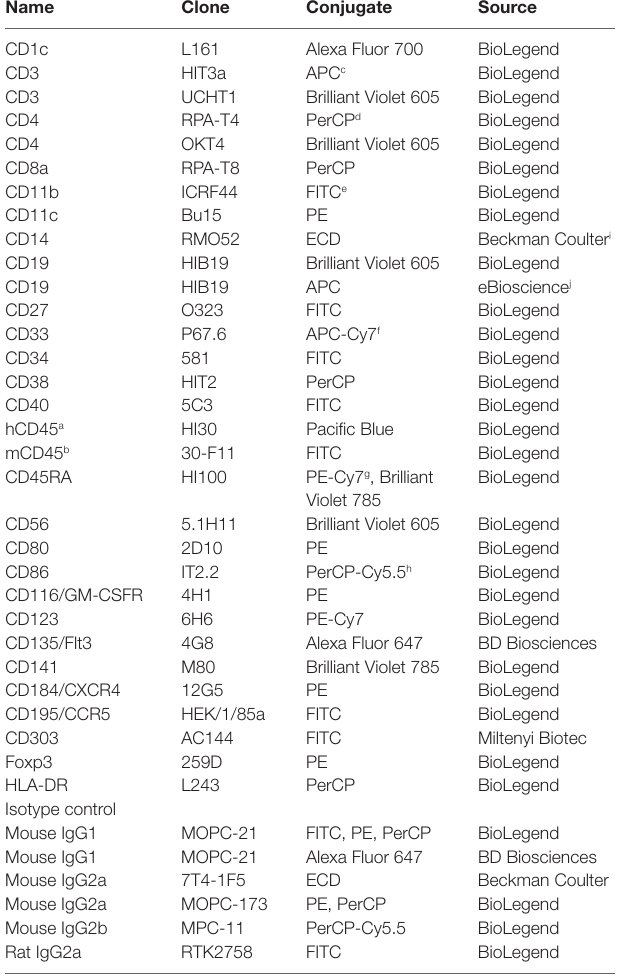
Table 1 | Monoclonal antibodies used for flow cytometry.